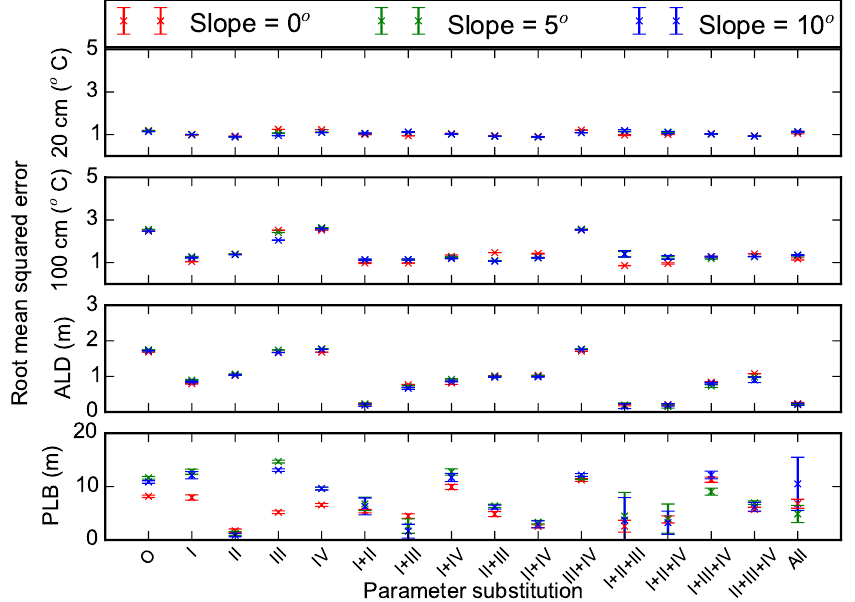
Figure 10. Root mean square errors between measurements and model simulations (with different combinations of measured porosity (I), thermal conductivity (II), hydraulic conductivity (III), and matric potential (IV) substituted for default loam parameters) for 20 and 100cm soil temperatures ( ◦ C), active layer depth (ALD, m), and permafrost low boundary (PLB, m). O and All represent model runs without substitution of default parameters and with all four parameters substituted. Mean and standard deviation of model simulations with three different soil thicknesses at each slope (0, 5, and 10 ◦ ) are